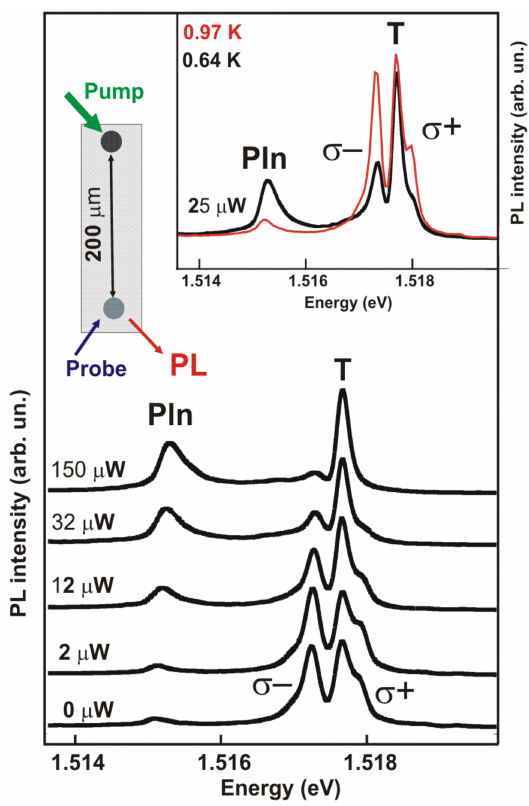
Figure 3. Photoluminescence spectra for sample 2 measured in the probing spot at a different pump power in the excitation spot. The left-hand inset shows the scheme of photoluminescence spectra measurements with the probing spot separated from the pumping spot by ~200 µ m. The right-hand inset shows the photoluminescence spectra measured in the probing spot at P pump = 25 µ W and different temperatures (0.64 and 0.97